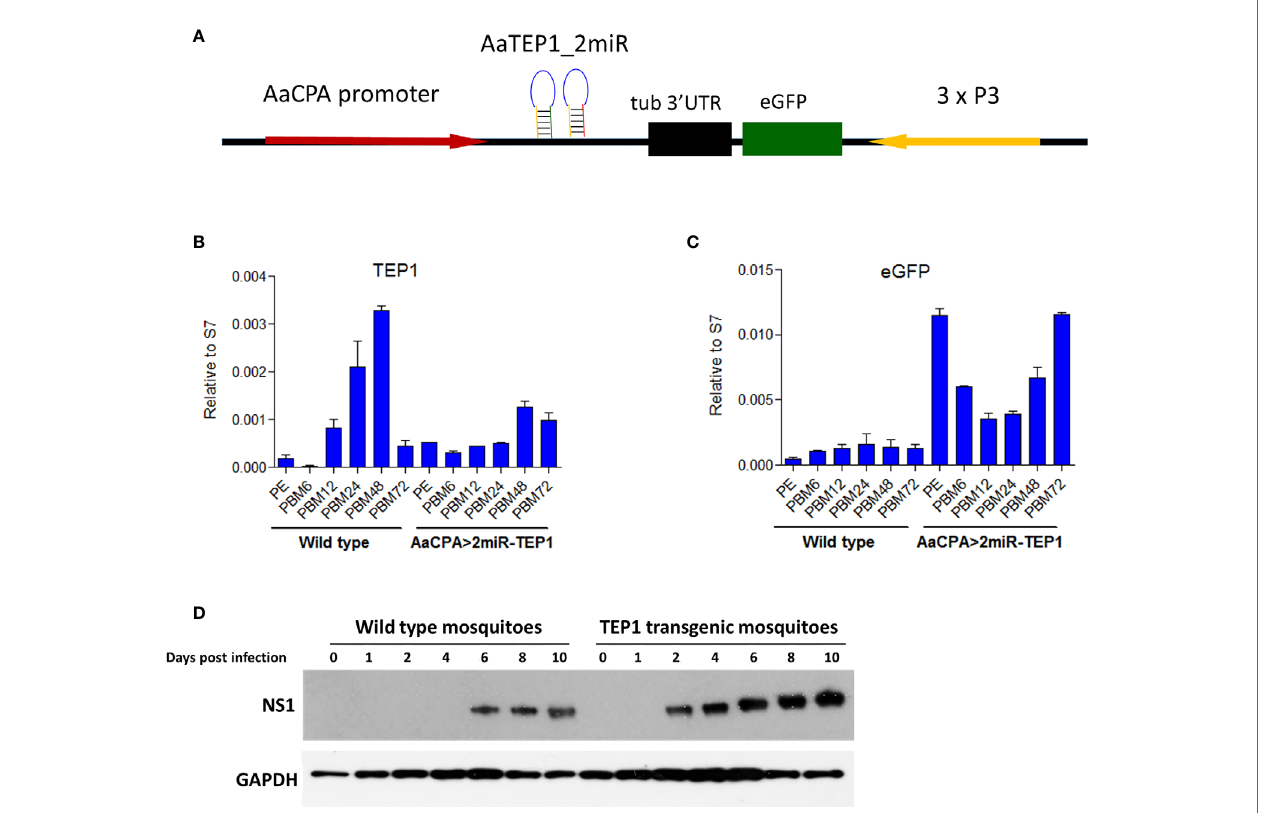
FIGURE 3 | Signal Pathways involved in Dengue Virus (DENV) Replication and Transmission in Aedes aegypti . (A) Development of a thioester-containing protein 1 (TEP1) loss-of-function transgenic mosquito line with a blood meal-inducible carboxypeptidase (CPA) promoter. Based on the mariner transposon system, the midgut-speci fi c blood meal-inducible CPA promoter (AaCPA) was used for expressing the downstream synthetic miRNAs. AaCPA promoter, Ae. aegypti carboxypeptidase A promoter; AaTEP1_2miR, anti-TEP1 miRNA. (B, C) miRNA-mediated TEP1 silenced transgenic mosquitoes. The whole bodies of female wild type or transgenic mosquitoes (AaCPA>2miR-TEP1) were collected 6, 12, 24, 48, and 72 hours after a normal blood meal. Total RNA was extracted and quanti fi ed, followed by cDNA synthesis and subjected to quantitative real-time PCR analysis with a speci fi c primer for TEP1 (B) or GFP (C) . Values are mean ± S.E. (error bars) of the ratio of each gene to ribosomal protein S7. At least three biological cohorts from each time point were used for analysis. Ribosomal protein S7 was used for normalization of the relative target gene mRNA expression. (D) Anti-DENV phenotype of transgenic mosquitoes. The whole bodies of female mosquitoes were collected 0, 1, 2, 3, 4, 6, 8, and 10 days after an infectious DENV blood meal. Total protein was extracted and western blot analysis was performed with the antibody against DENV NS1 protein. Anti-GAPDH antibody was used as the loading control. PE means